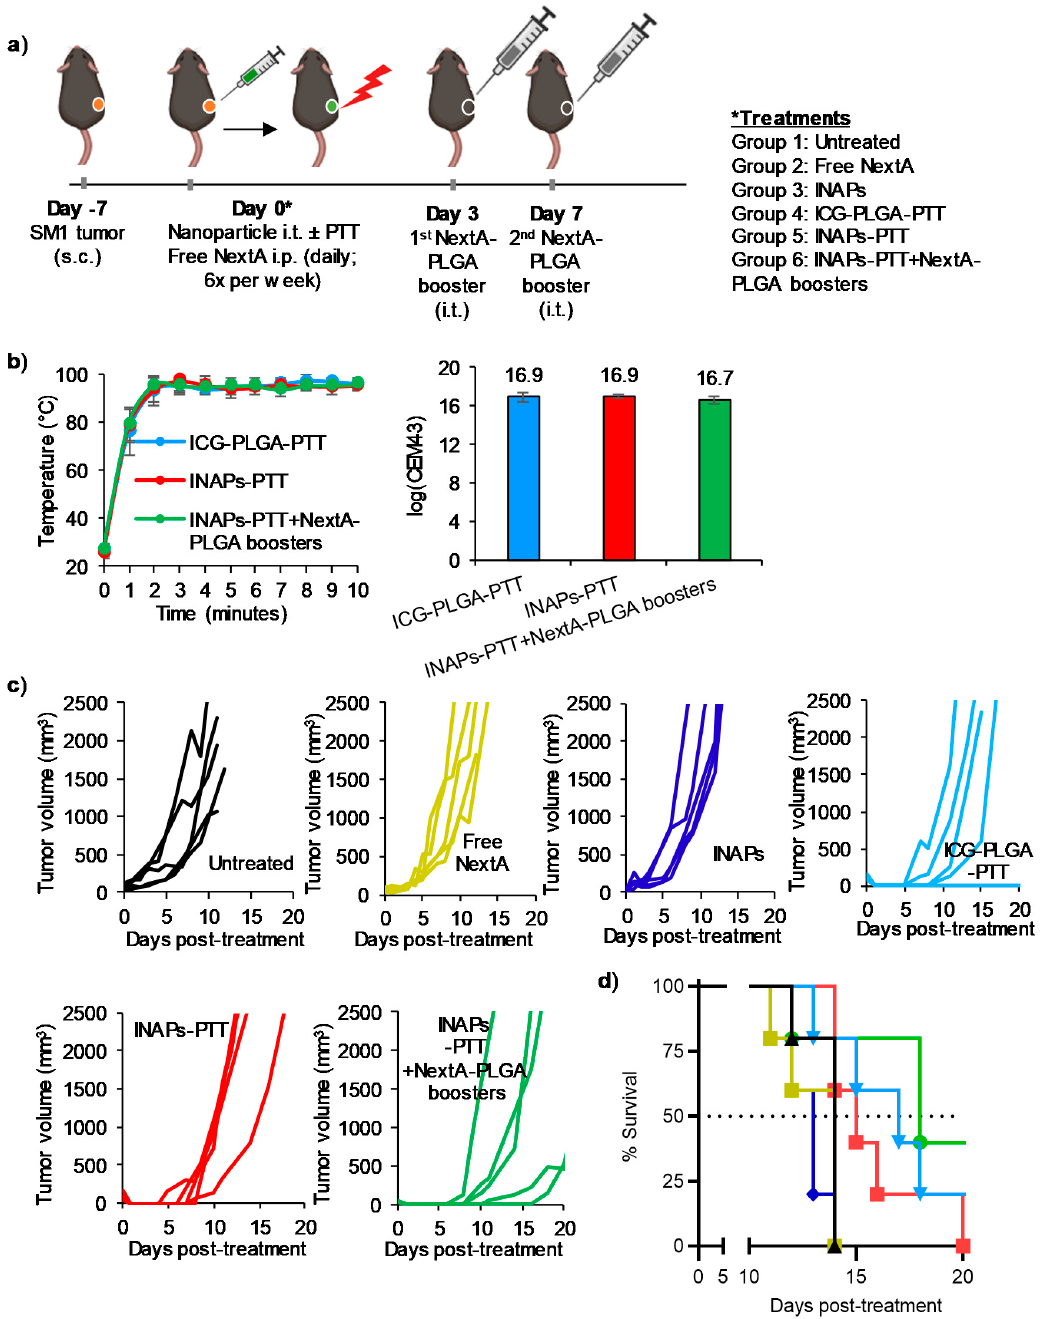
Figure 6. INAPs-PTT slows tumor progression and increases median survival in local melanoma-bearing mice. SM1 melanoma cells were inoculated on the right flank of C57BL/6 mice. ( a ) Schematic for the combination therapy in a primary tumor model. ( b ) Temperatures for PTT groups were measured every minute by a thermal camera and maintained at approximately 95 °C, with the corresponding log(CEM43) ~16.9. ( c ) Individual tumor growth curves ( n = 5/group) and ( d ) the overall Kaplan–Meier survival plots demonstrate short-term delay of tumor recurrence and increased median survival with sustained epigenetic therapy after PTT (INAPs-PTT + NextA-PLGA boosters).